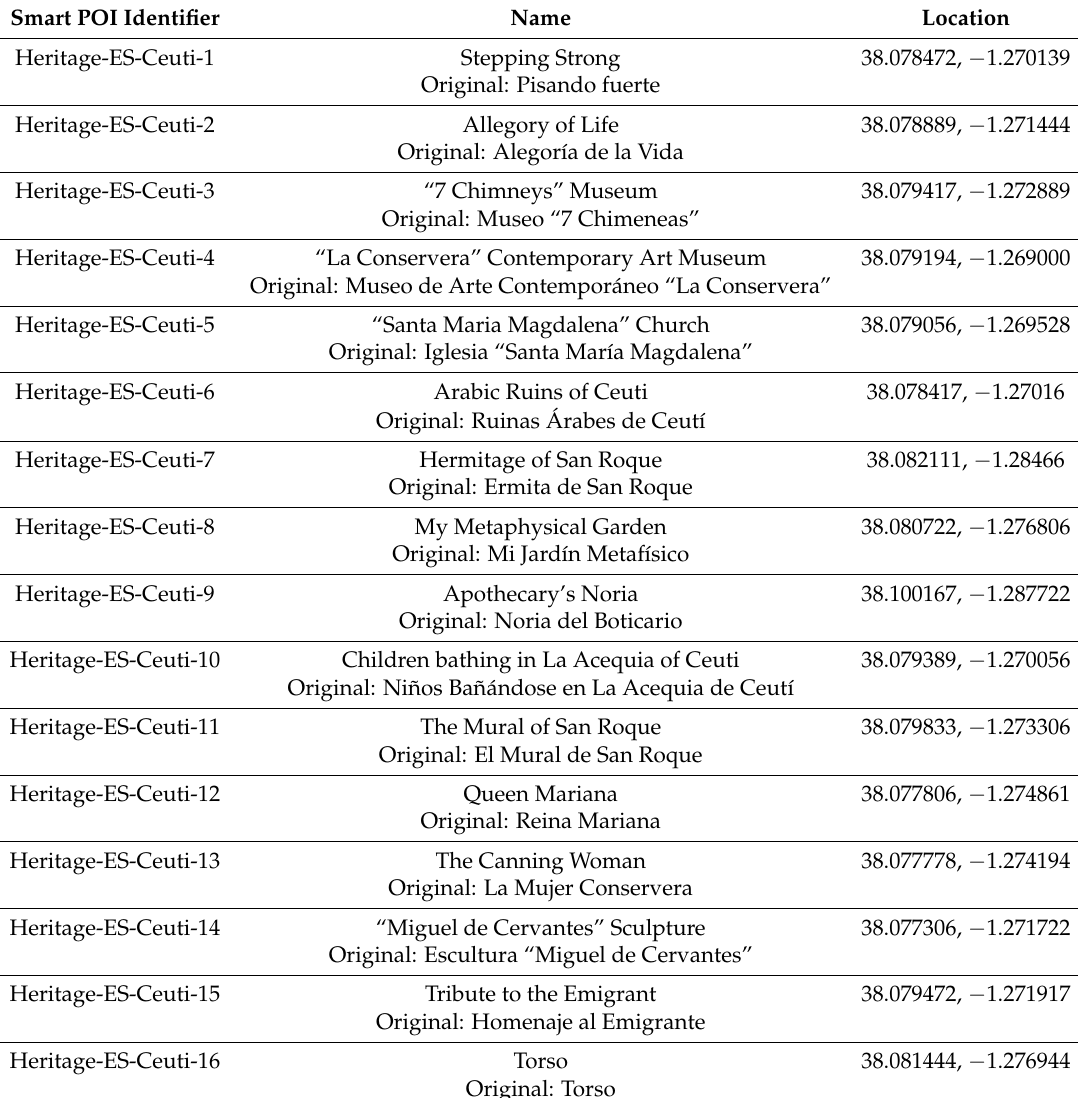
Table A1. Smart POIs